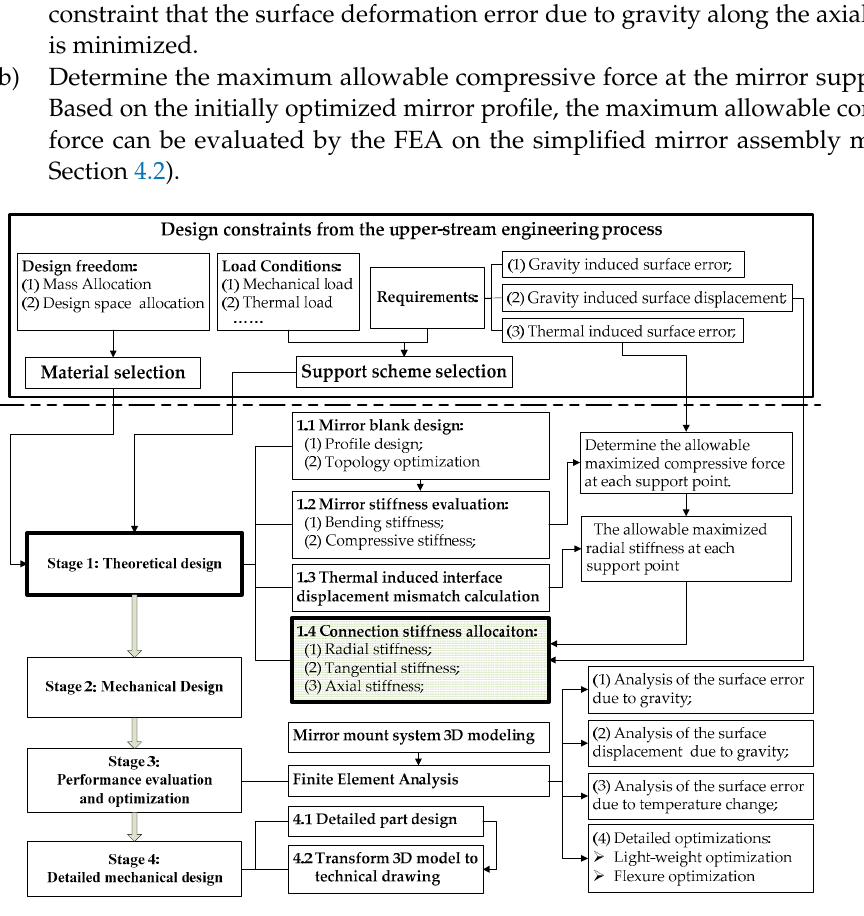
Figure 5. Mirror mount system design process.